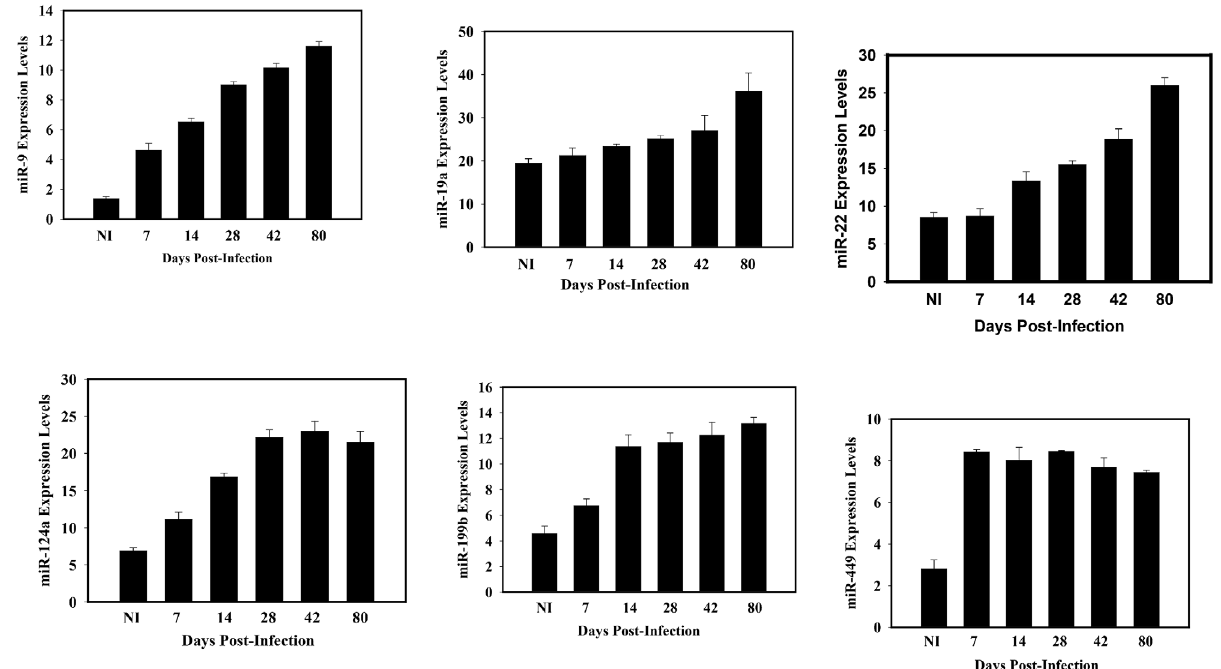
Fig 2. Chlamydial genital infection caused a sustained alteration of key miRNAs that control the functional integrity of epithelial cells (up- regulated miRNAs). Results were obtained as described in Fig 1 and selected miRNAs that were up-regulated have been